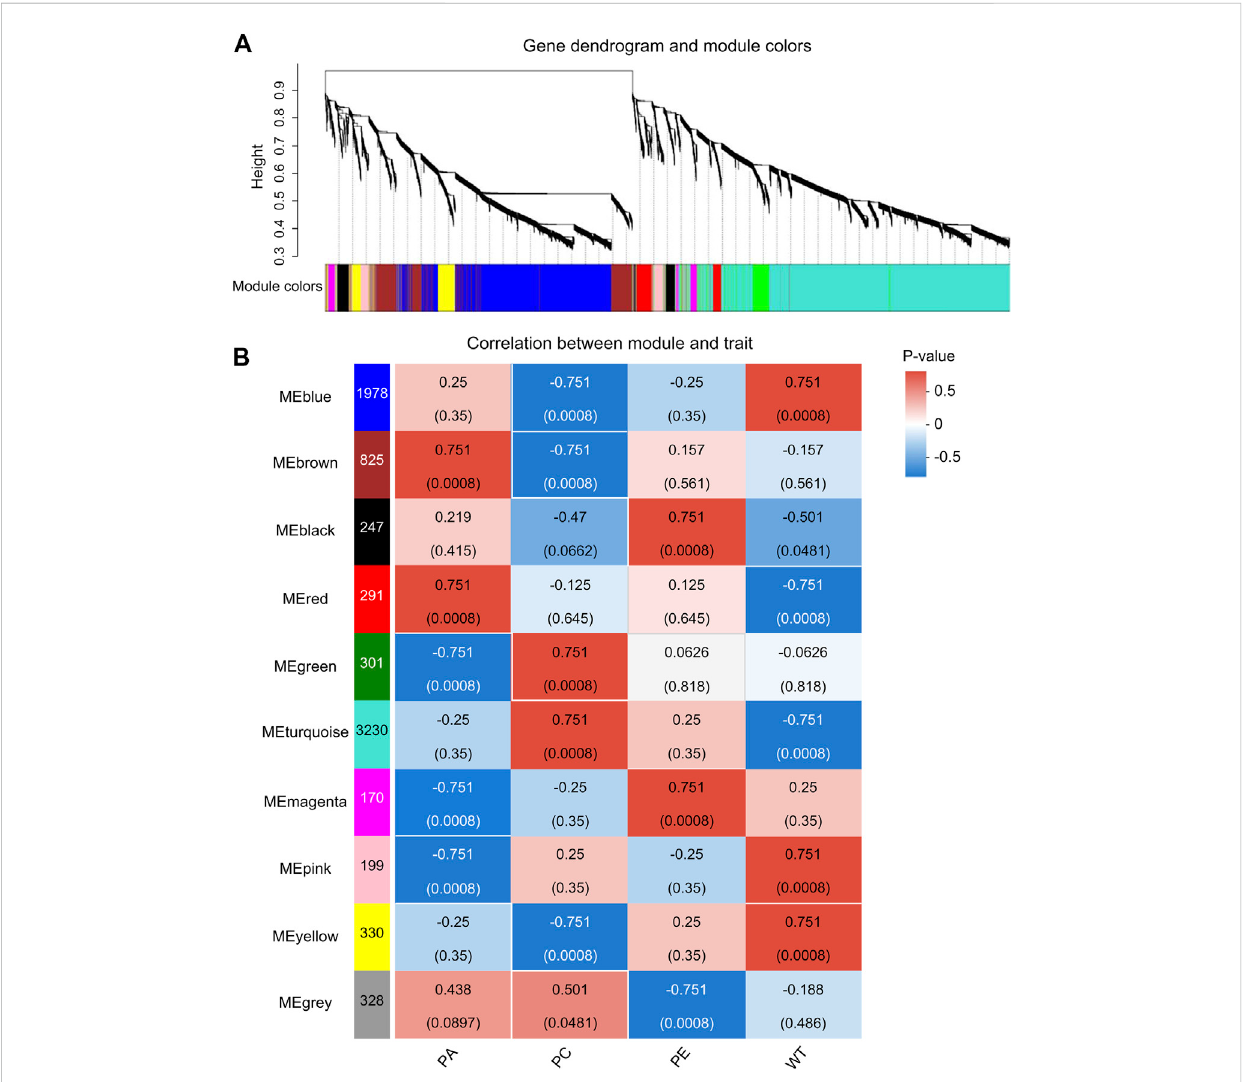
FIGURE 7 Analysis of expression patterns in tomato samples by WGCNA. (A) A module classi fi cation tree. Each branch of the cluster tree represents a module, with each leaf representing a gene. Each color represents a module. If the color is gray, the genes did not divide into speci fi c modules. (B) A module- sample association heatmap. The abscissa represents the different samples, and the ordinate represents the different modules. The column on the left represents the number of genes in the module, while each group of data on the right represents the correlation coef fi cient (r) and p -value (in parentheses)between thegeneinthemoduleandthesample. Redandbluerepresentpositive andnegativecorrelations betweenmodulesandsamples,